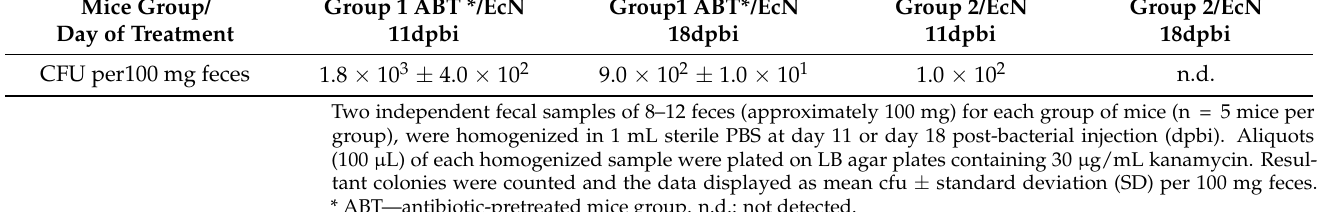
Table 5. Detectable CFU of EcN/pMUT-gfp Kn r (EcN) bacteria in feces of 4T1 tumor-bearing mice. Mice Group/ Group 1 ABT */EcN Day of Treatment 11dpbi CFU per100 mg